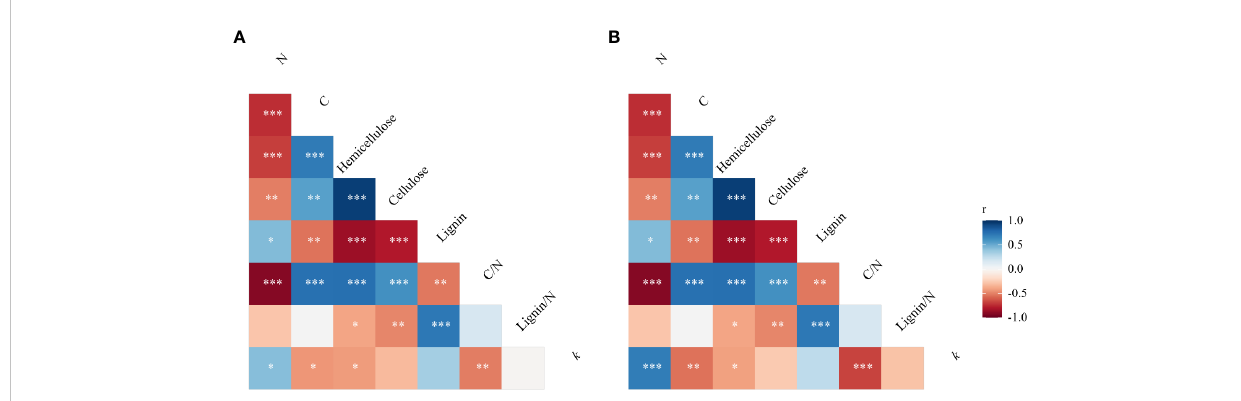
FIGURE 2 Pearson correlation matrix of potential relationships between decomposition rate ( k ) and initial straw quality (concentrations of C, N, cellulose, hemicellulose and lignin, C/N ratio and lignin/N ratio) in (A) experiment I and (B) experiment III. Associations are colored by direction of effect (blue, positive; red, negative), with associations signi fi cant (* P < 0.05, ** P < 0.01, *** P < 0.001).